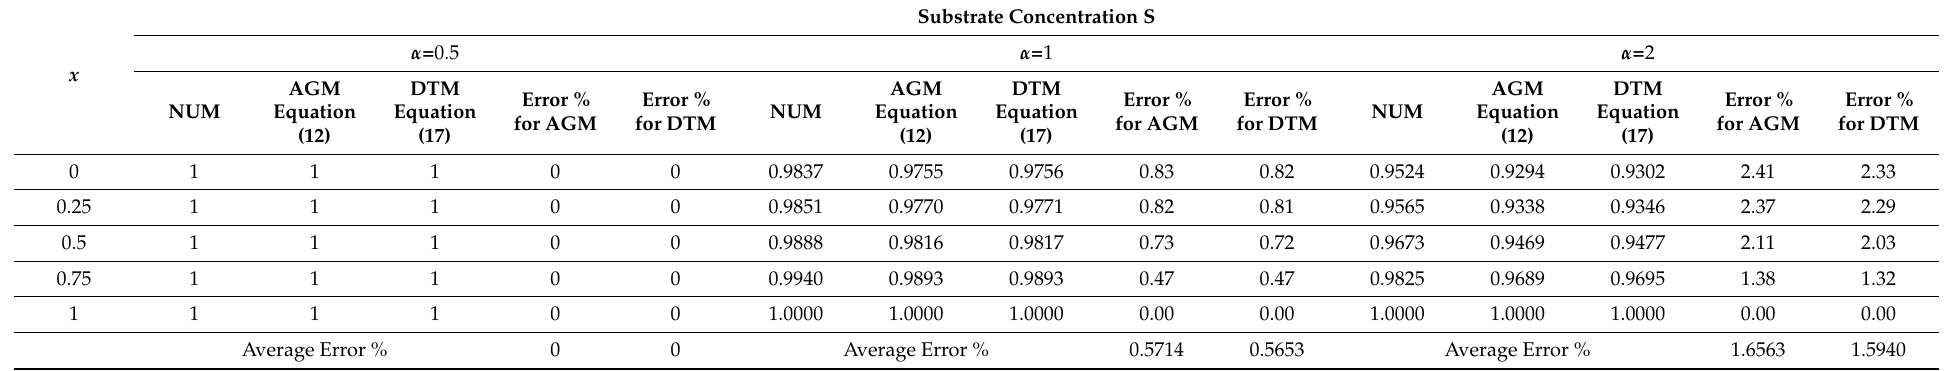
Table 2. Comparison between the numerical and analytical expression of the concentration of the substrate obtained by AGM and DTM for the parameters k = 0.1, γ = 0.5, and for different values of α